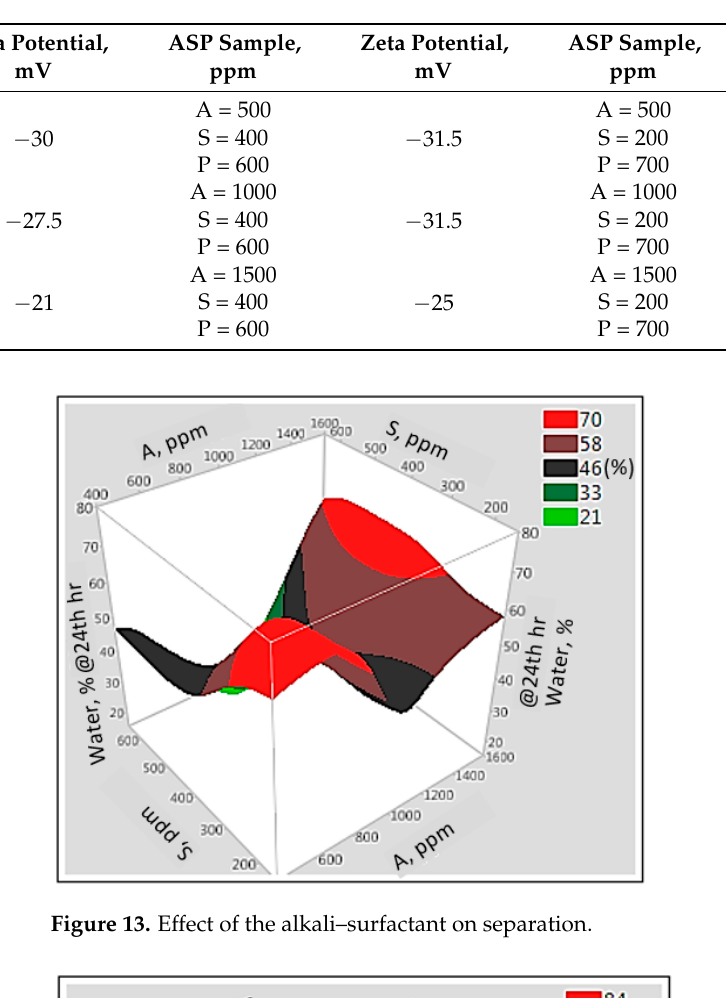
Figure 15. E ff ect of the alkali–polymer on separation. The interaction of the polymer with a high concentration of surfactant stabilized the emulsion, and the separation was around 20%. The interaction of the surfactant and alkali